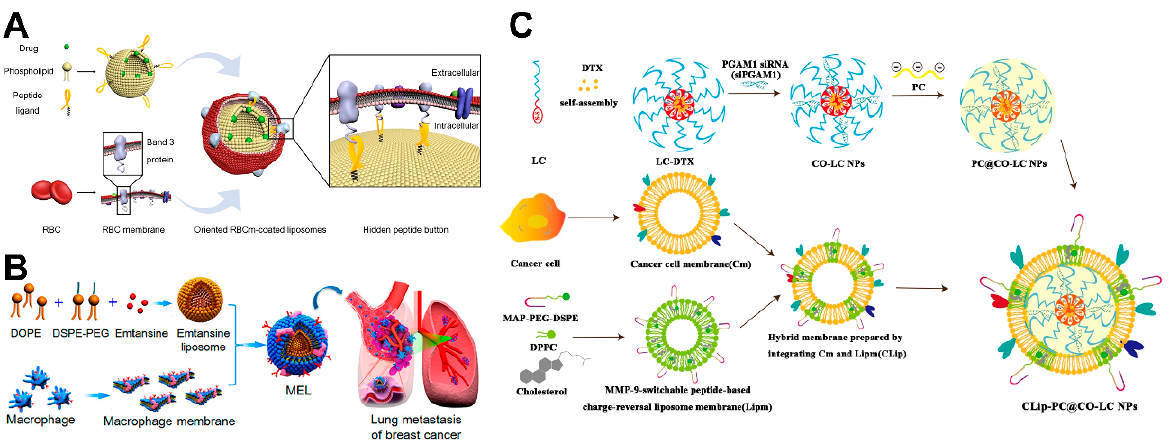
Figure 4. Schematic of several cell membrane-coated liposomes. ( A ) Schematic diagram of erythrocyte membrane and cationic liposome assembly. Reproduced with permission from [111]. Copyright 2019, American Chemical Society. ( B ) Schematic diagram of macrophage membrane-coated liposomes. Reproduced with permission from [112]. Copyright 2016, American Chemical Society. ( C ) Schematic diagram of membrane-coated liposomes in cancer cells. Reproduced with permission from [120]. Copyright 2021, the author(s).